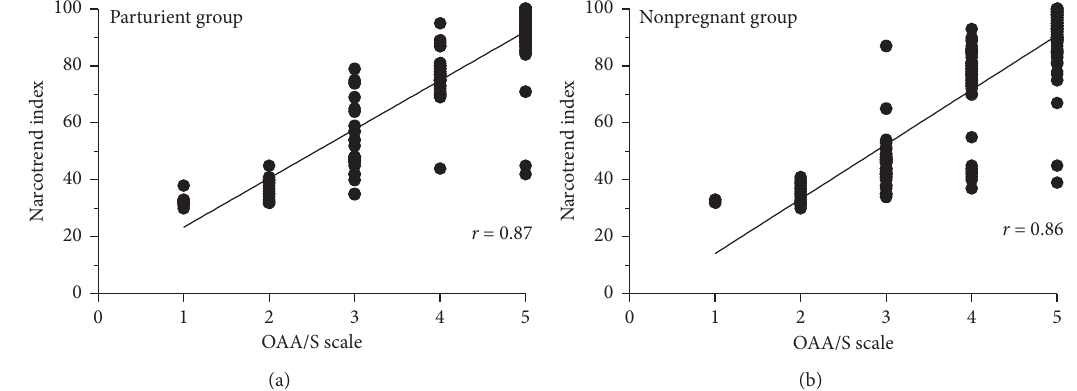
Figure 3: The correlation between Narcotrend index and OAA/S scale under dexmedetomidine sedation with spinal anesthesia in both groups. r , correlation coefficient.